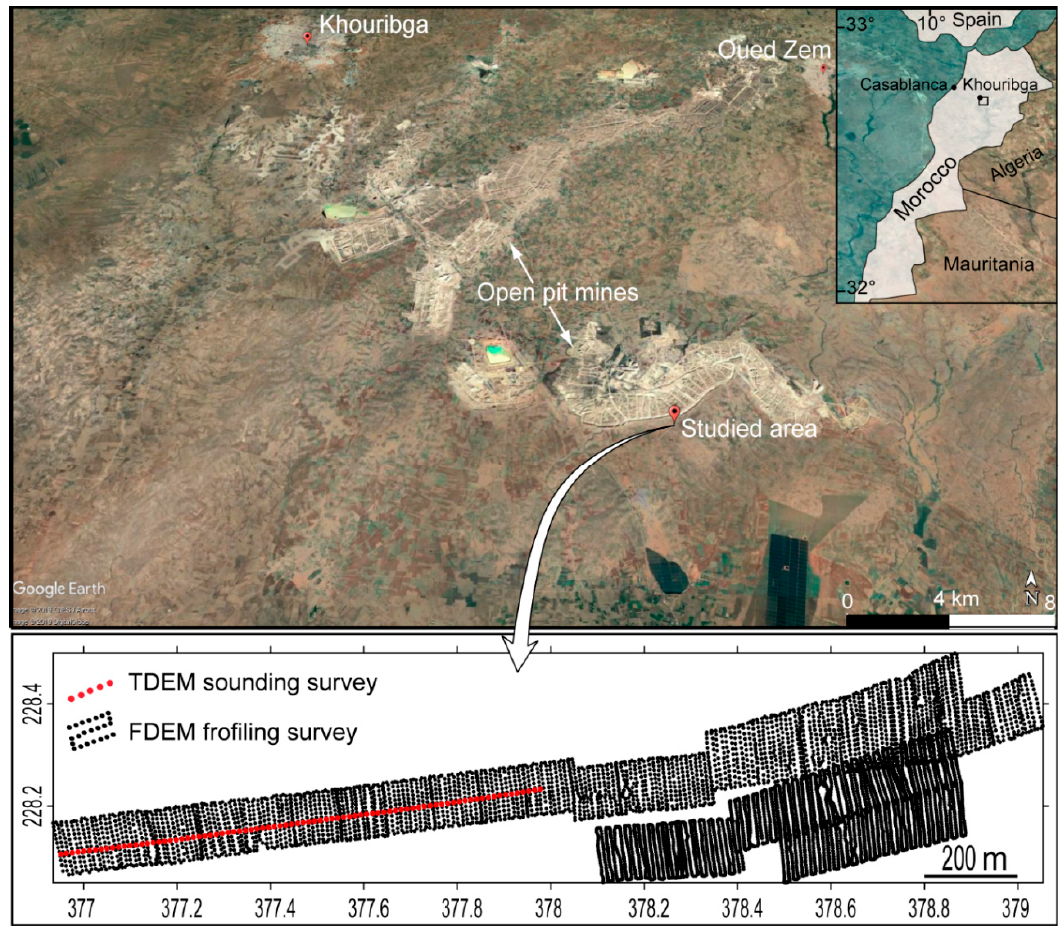
Figure 3. Location of geophysical surveys conducted in Khouribga area.